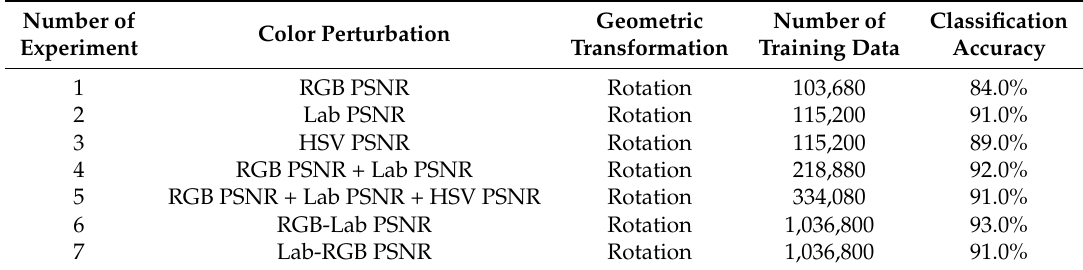
Table 6. Classification accuracy obtained upon applying the inverse PSNR method and Geometric Transformation #2: